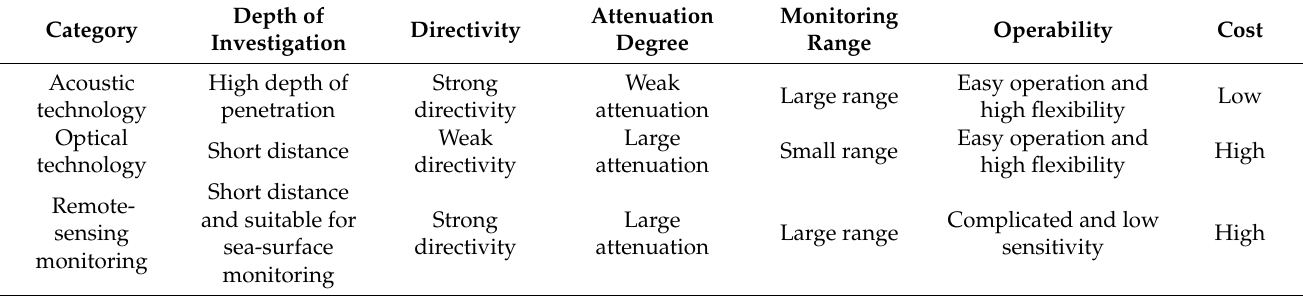
Table 1. Technology